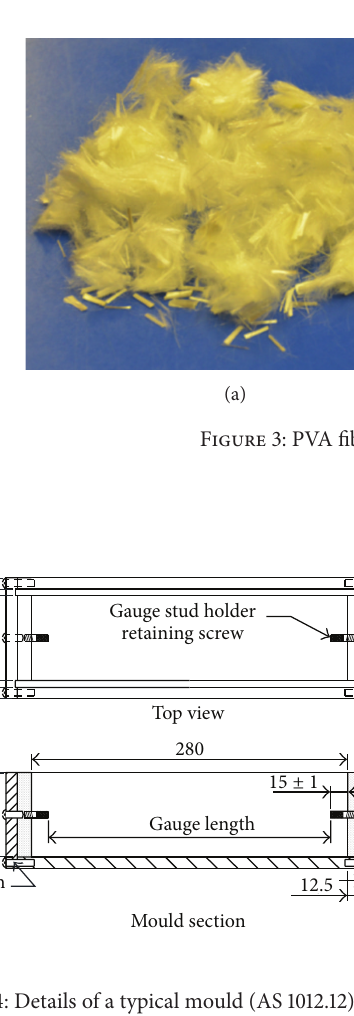
Figure 4: Details of a typical mould (AS